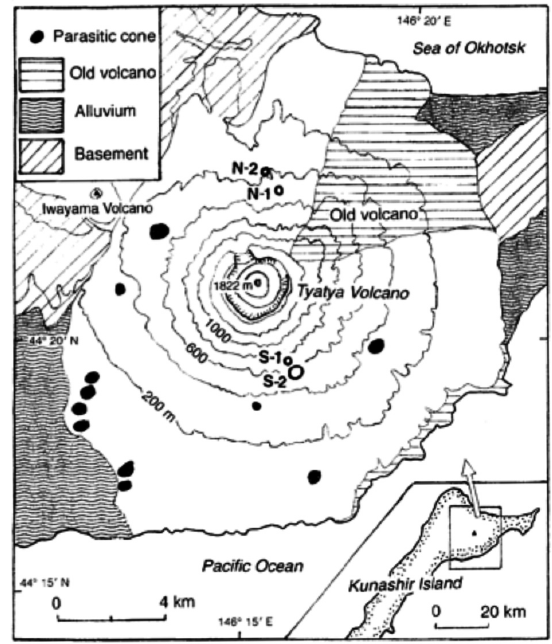
Figure 12. The 1970 eruption of Hekla volcano (after Thorarinsson and Sigvaldason [1972]); HLI and H: the 1947 vents; OLD: Ölduígagr lava; Sud: Sudurgígar lava; TOP and AXL: Summit craters.